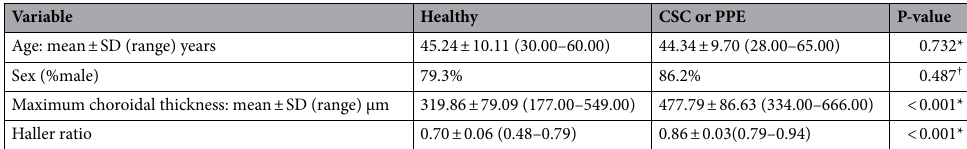
Table 4. Demographics and choroidal metrics for patients with central serous chorioretinopathy or pachychoroid pigment epitheliopathy and healthy subjects in the testing dataset. CSC central serous chorioretinopathy, PPE pachychoroid pigment epitheliopathy, SD standard deviation. *Student t test. † Chi- square test.